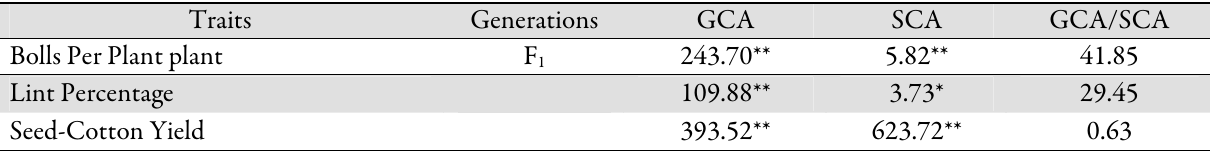
Table 1. Values of GCA/SCA, mean square of GCA and SCA of investigated